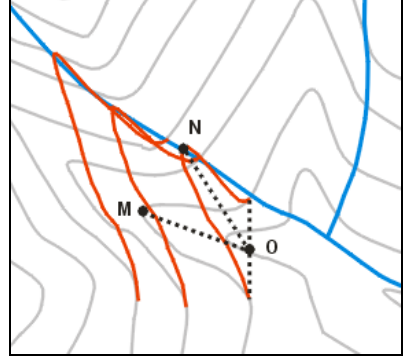
Figure 9. Contours intersected after